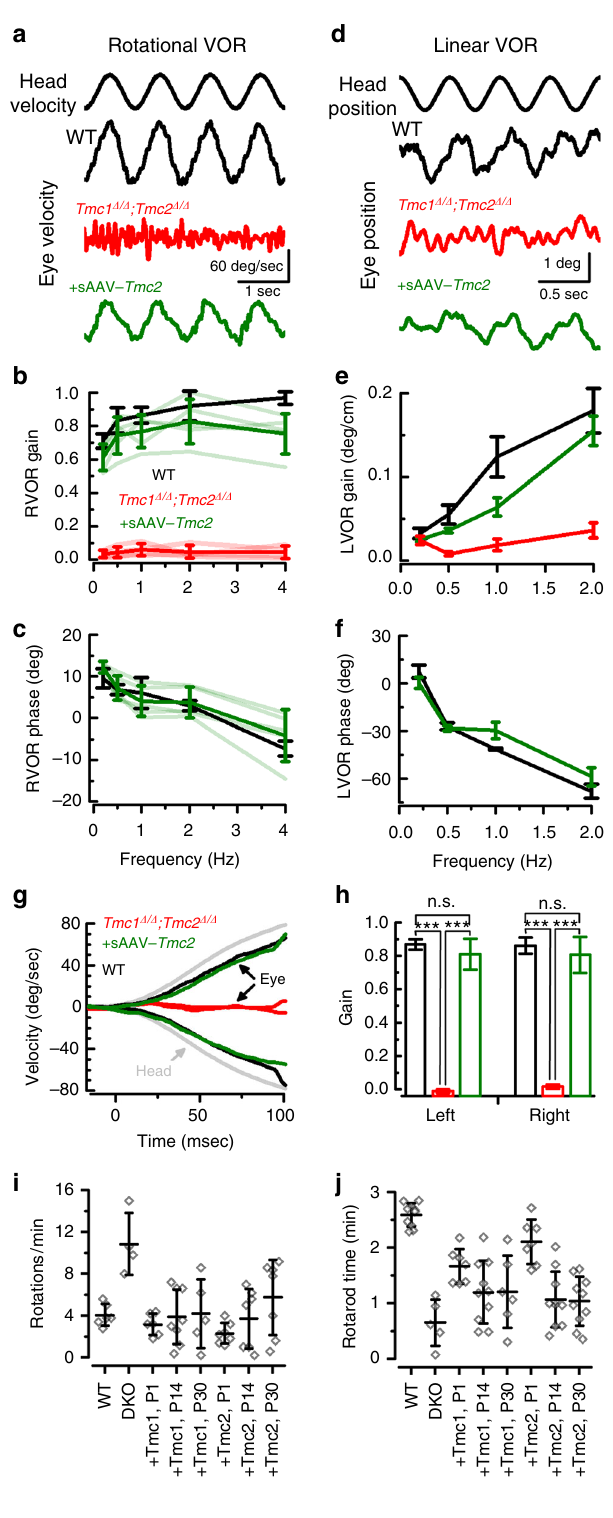
phases (Fig. 5c) for 14 mice are summarized for the three groups of mice. While the WT group ( n = 5) exhibited high gain com- pensatory RVORs at all frequencies tested, the Tmc mutant mice ( n = 4) exhibited virtually zero gain responses at the same fre- quencies and thus displayed little difference from responses of a dead mouse. However, the sAAV- Tmc2 -treated group ( n = 5) exhibited robust compensatory RVORs at these frequencies.